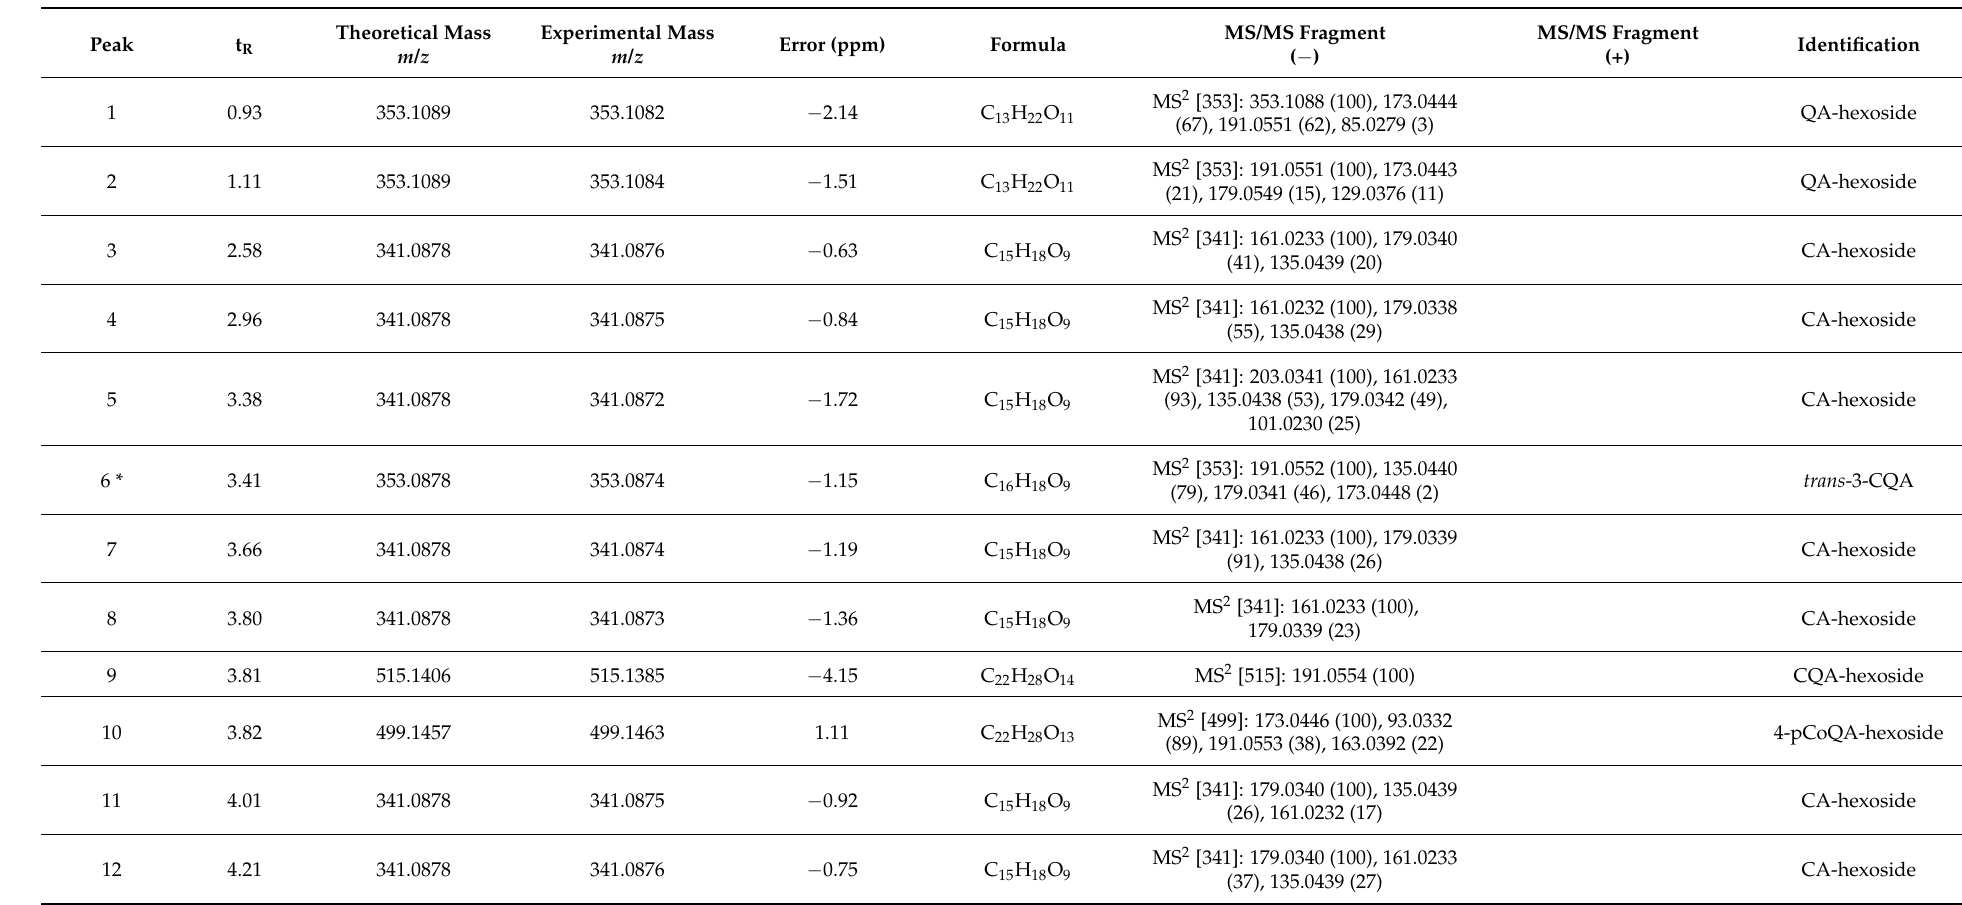
Table 1. Retention times and mass spectral data of Cephalanthus tetrandrus (Roxb.) Ridsd. et Badh.